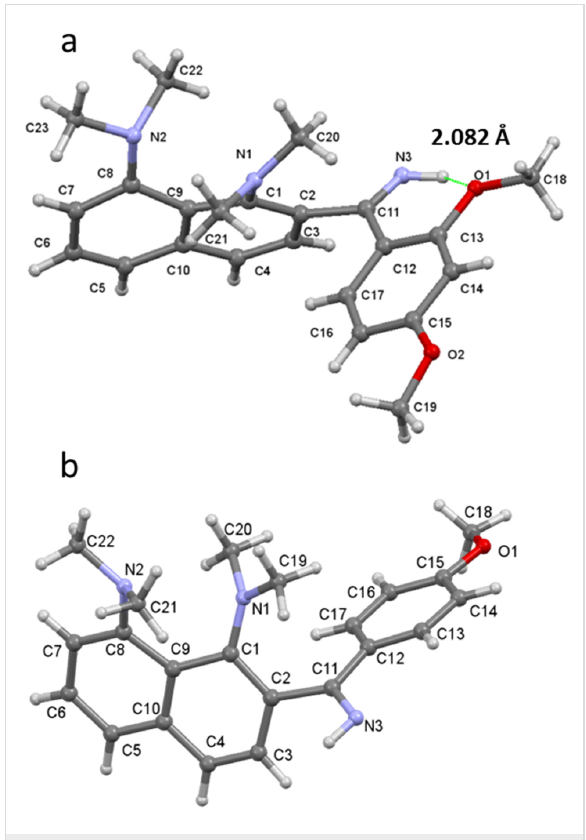
Figure 2: Molecular structure of imines 6a (a) and 4a (b). The H···O distance for 6a is shown.